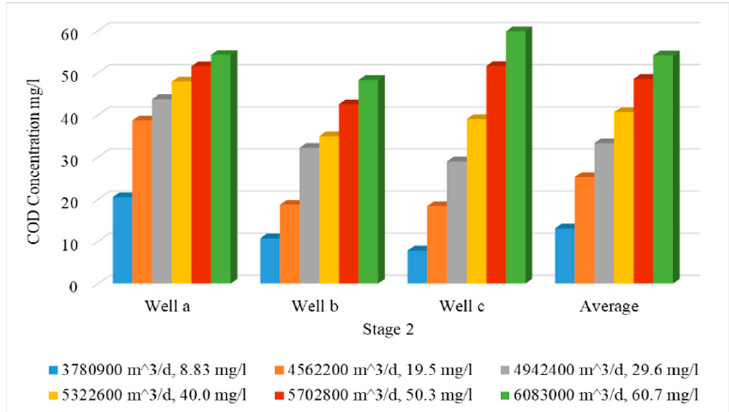
Figure 9. Comparison between COD concentration at observation wells for different scenarios (7–11) of stage 2.